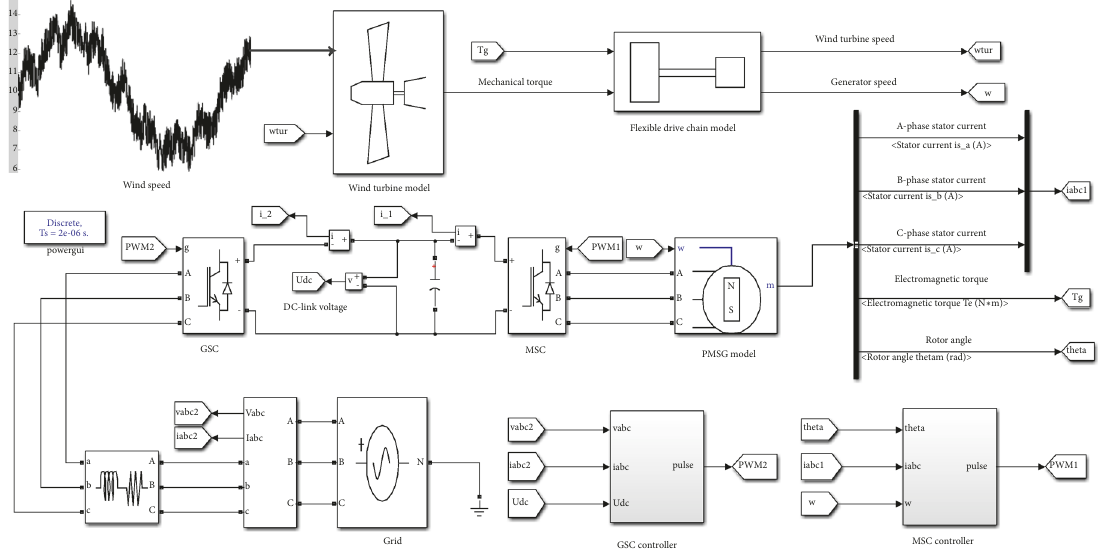
Figure 3: Simulation test platform.